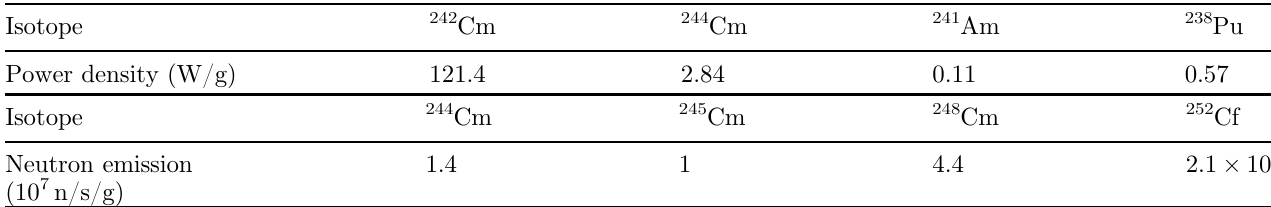
Table 3. Isotopes used for residual power calculations and neutron source calculations. Isotope 242 Cm Power density (W/g)